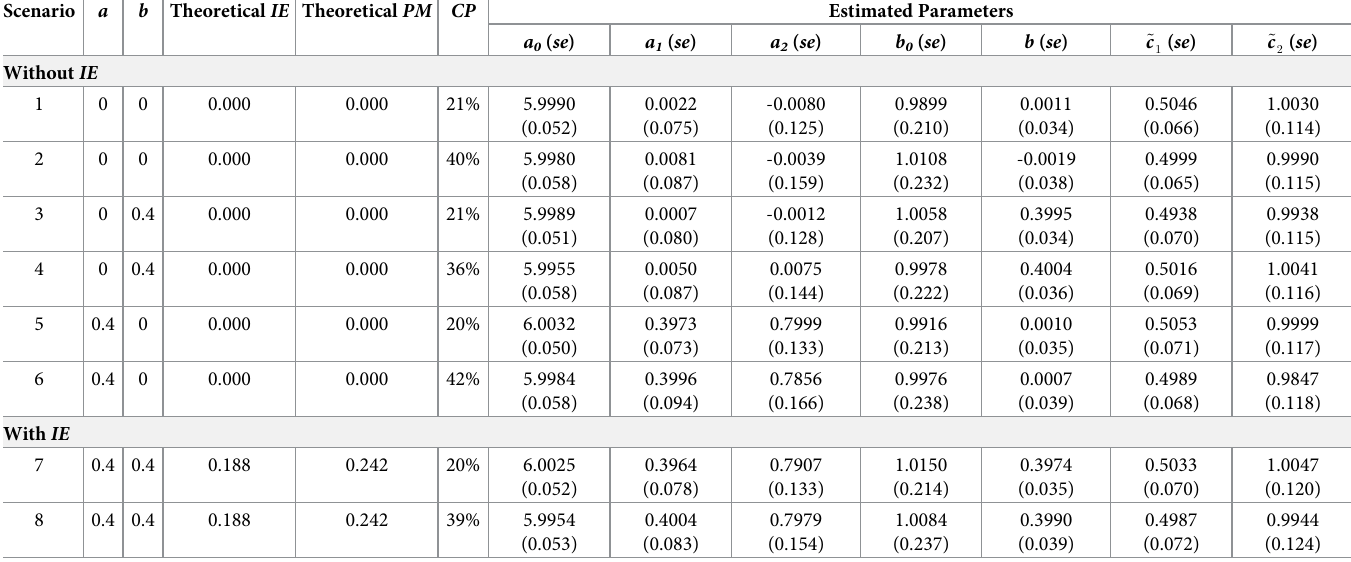
Table 3. Continuous outcome: Means and standard errors (se) of estimated coefficients for different paths, a 0 , a 1 , a 2 , b 0 , b , ~ c quency (MAF) = 0.3. Scenario a